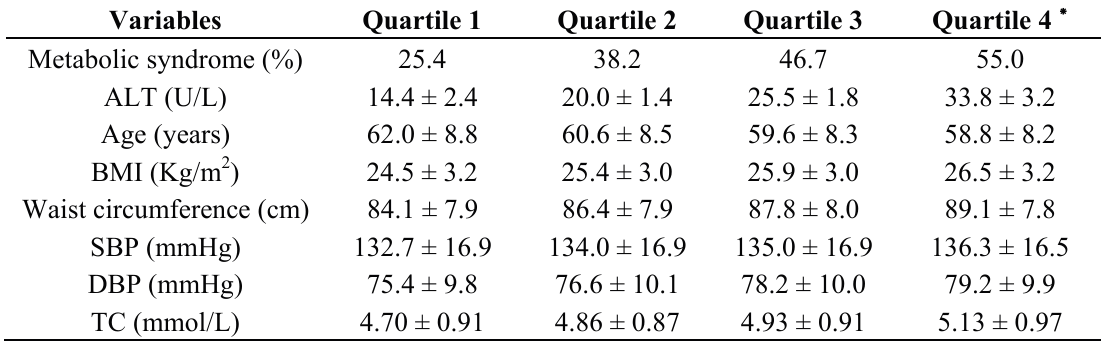
Table 2. Characteristics of participants stratified by ALT quartiles in